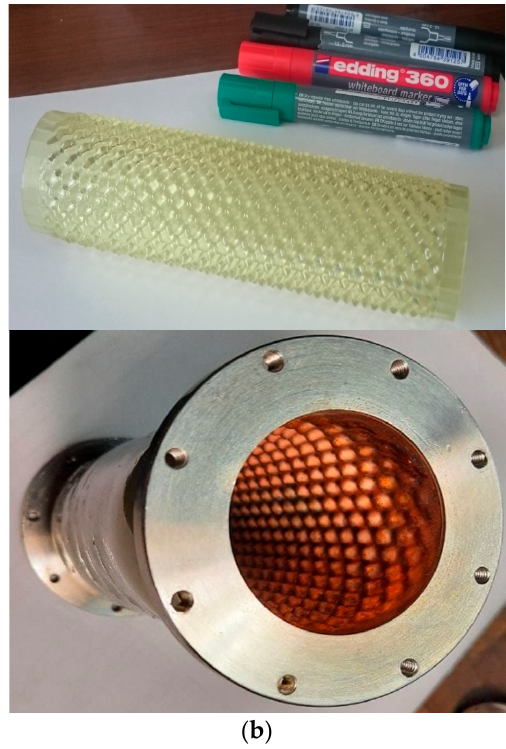
Figure 14. Photographs of the prototypes of the 2D-periodical slow-wave structures for Ka-band SWO manufactured using different technologies: ( a ) “conventional” copper electroplating technology and ( b ) novel CMPS technology ( upper —the photopolymer 3D printed mandrel, lower —the 2D slow-wave structure after coating the copper layer and melting the mandrel).